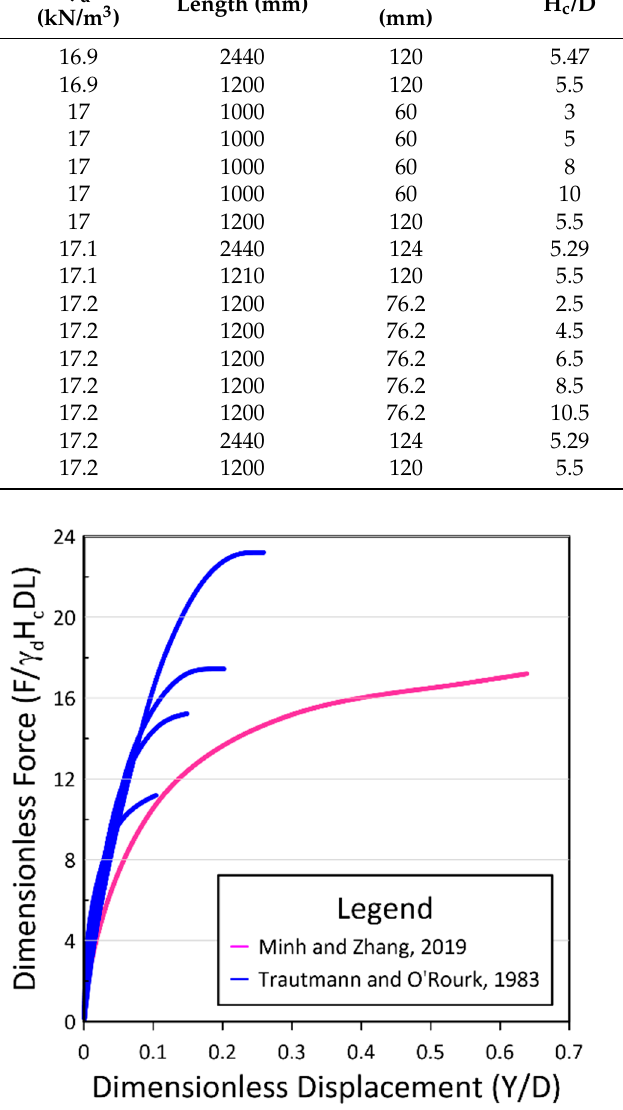
Figure 4. Dimensionless force vs. displacement test data for dense sand (16.7 kN/m 3 < γ d ≤ 17.5 kN/m 3 ). Experiments performed by [7,18]. Table 3. The parameters used for each very dense sand test with the corresponding researcher.